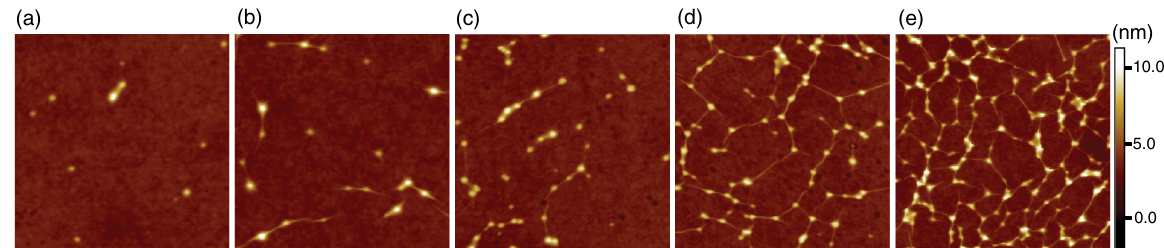
FIG. 1. AFM images ( 1 (cid:2) 1 (cid:3) m 2 ) of graphene on SiO (c) 49, (d) 90, and (e) 170 (cid:3) m (cid:3) 2 ,